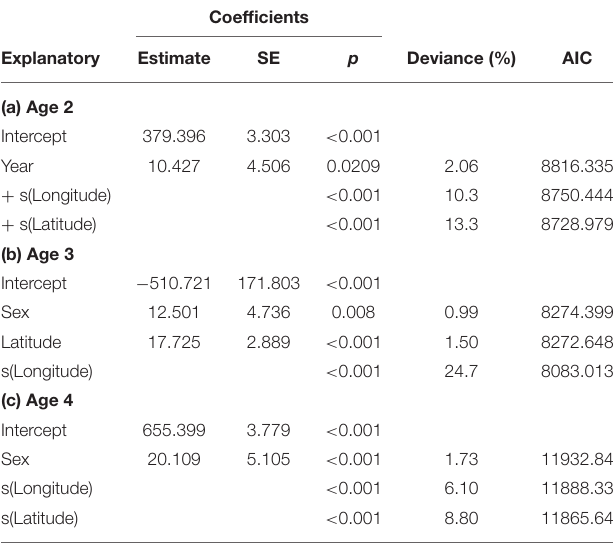
TABLE 2 | GAM model coefficients, deviance explained and AIC for length in relation to year, longitude, latitude and sex for ages